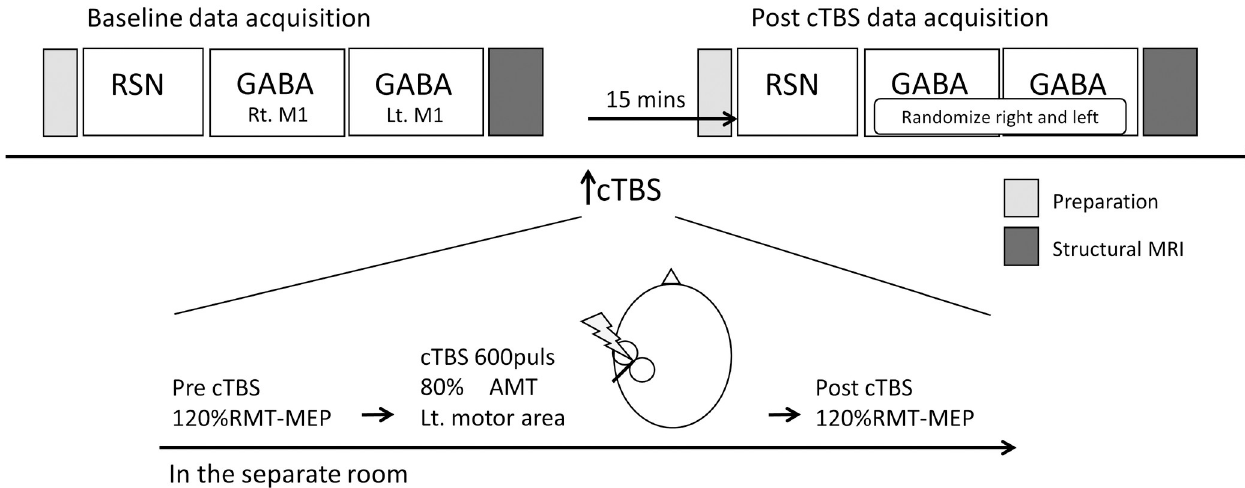
Fig 1. Experimental protocol. After baseline data acquisition, subjects were removed from the MRI gantry and taken into a separate room for continuous theta-burst stimulation (cTBS), which was administered at 80% AMT for 600 pulses. MEPs were measured at 120% RMT before and after cTBS. The subjects were then transferred to the MRI room. Data for post-cTBS GABA-MRS were obtained approximately 15 min after the TMS protocol, with right and left data collected in a randomized order.